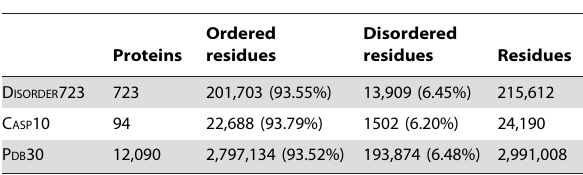
Table 1. Composition of